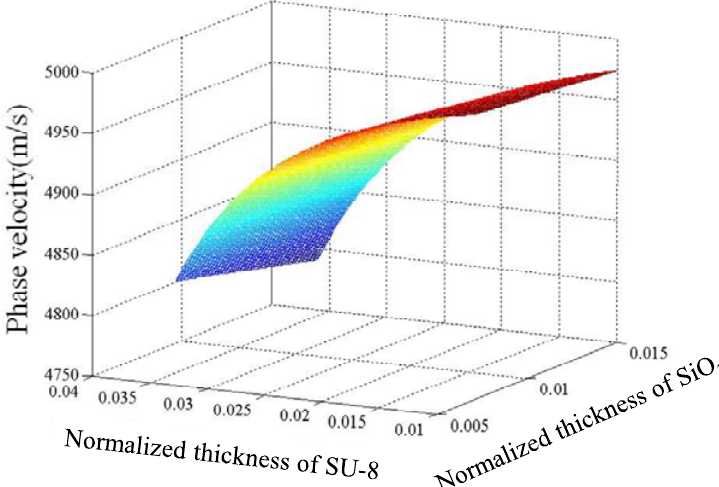
Figure 3. Phase velocity versus normalized layer thickness in a layered structure of /SU-8 at room temperature of 25 °C. ST-90°X quartz/SiO 2